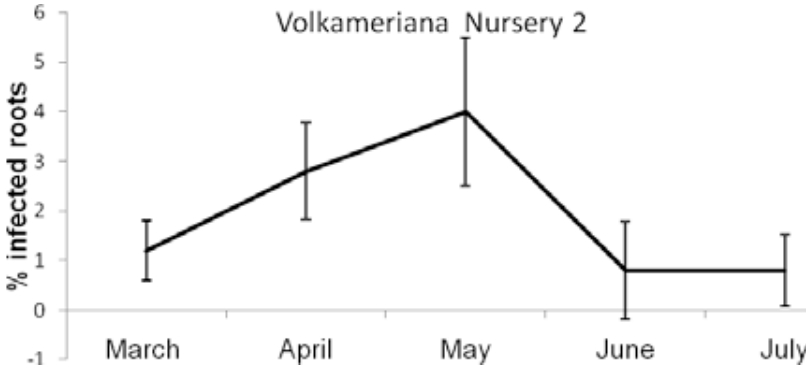
Figure 4. Percentage of feeder roots infected by Phytophthora spp. in Nursery 2.